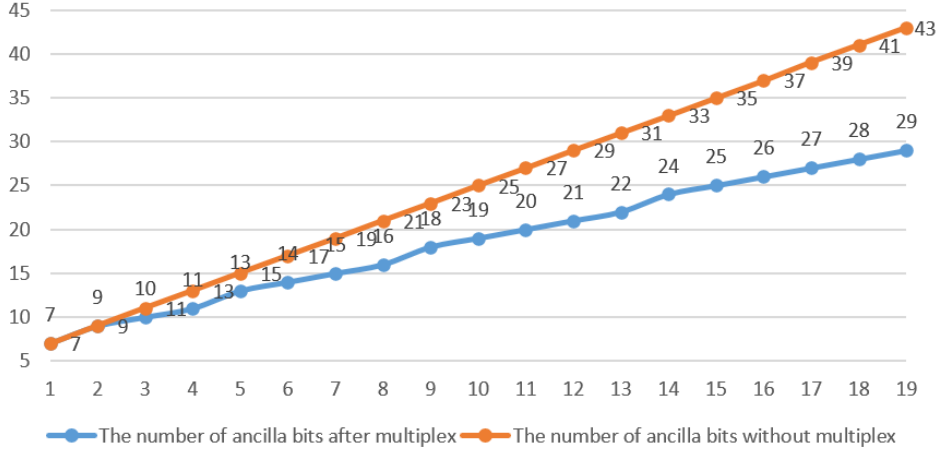
Figure 9. The difference in the number of qubits before and after multiplexing the ancilla bits.